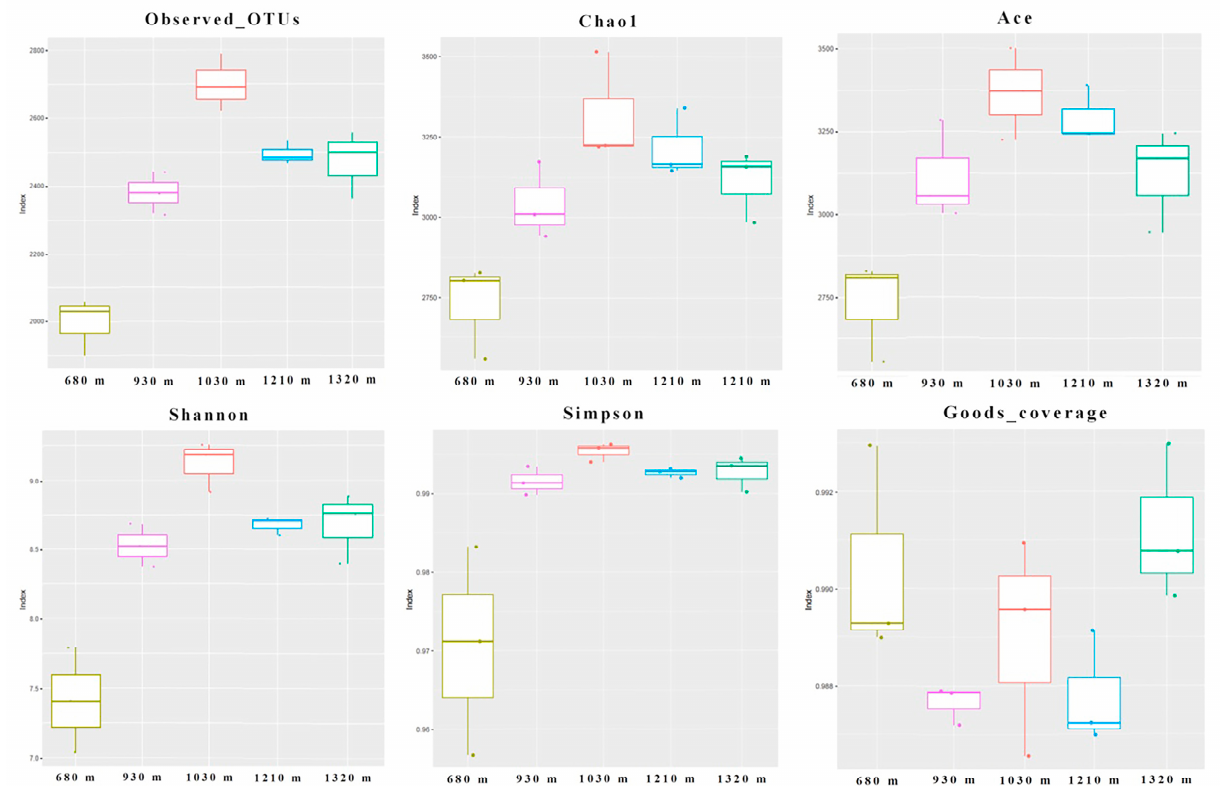
Figure 5. Alpha diversity indices of the bacterial communities (based on the 16S rRNA genes) in the C. arabica rhizospheric soil samples at different altitudes. Data are presented for the rhizospheric soil samples collected at altitudes of 680, 930, 1030, 1210, and 1320 m.